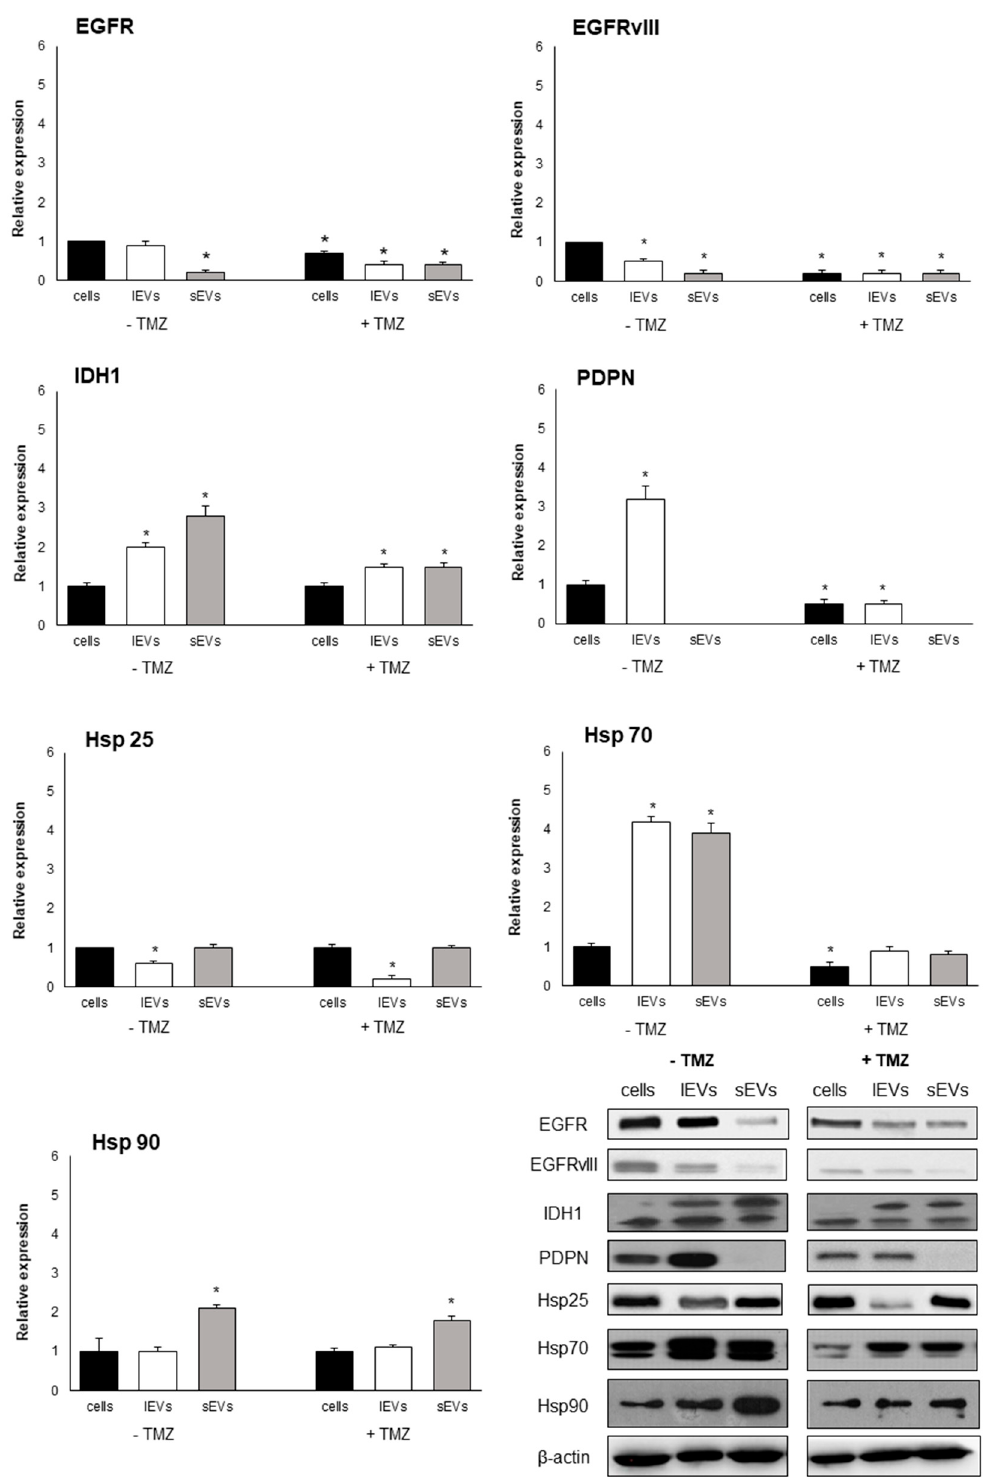
Figure 3. The expression levels of epidermal growth factor receptor (EGFR), EGFRvIII, isocitrate dehydrogenase 1 (IDH1), podoplanin (PDPN), Hsp25, Hsp70, and Hsp90 in U-87 MG cells and in isolated lEVs and sEVs after 200 µM temozolomide (TMZ) for 48 h treatment evaluated by Western blotting analysis. The expression of EGFR, EGFRvIII, IDH1, and PDPN is normalized with the housekeeping protein ( β -actin) and reported as relative expression respect to parental cells. The values for all experimental groups reported in the histograms represent the means ± SD ( n = 3) of three independent experiments; (*) p < 0.05 compared to respective origin cells. Representative images of proteins blots are reported.